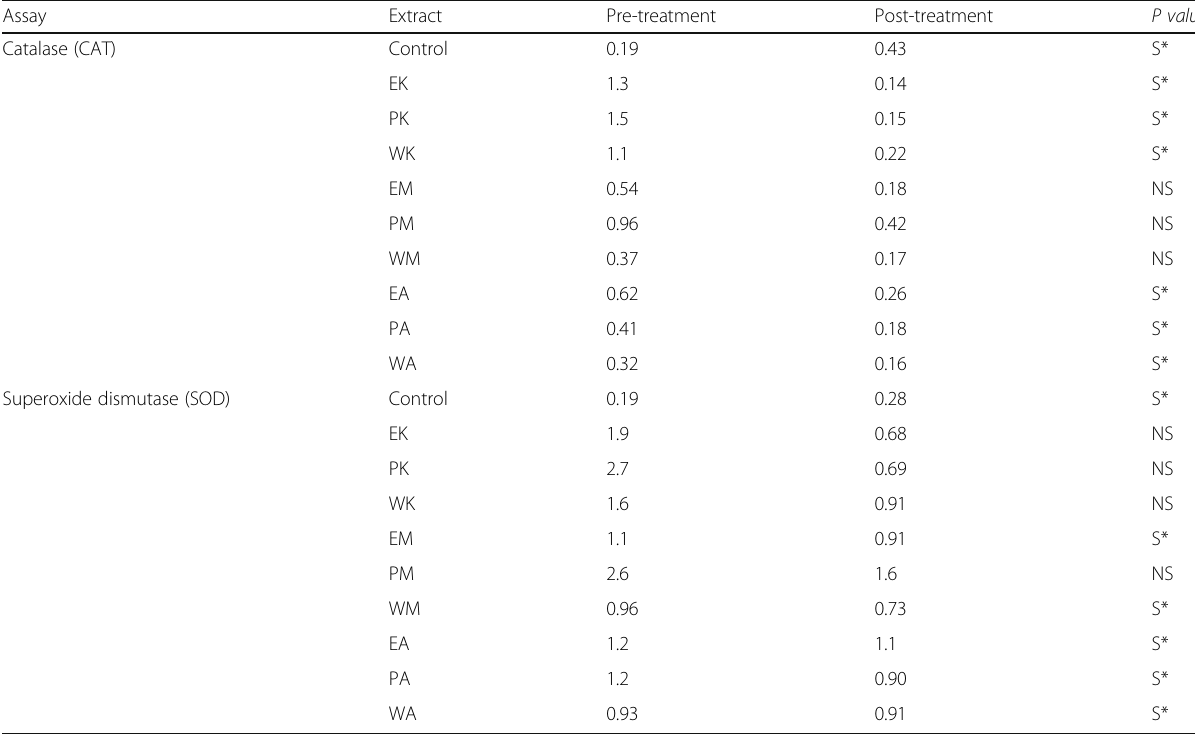
Table 3 Pre and post-treatment of catalase and superoxide dismutase activity of herbal extracts Assay Extract Pre-treatment Post-treatment P value Catalase (CAT) Control